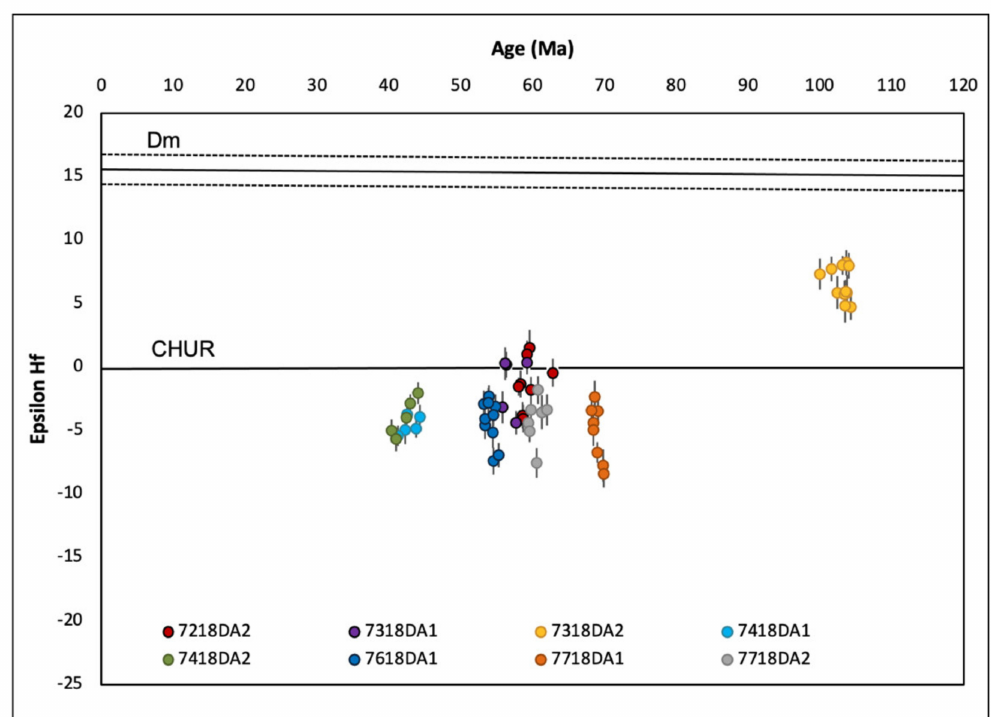
Figure 5. Epsilon Hf ( 176 Hf/ 177 Hf) values for igneous zircons plotted against corresponding U-Pb geochronology crystal- lization ages. More negative values represent more evolved isotopic signatures. Chondritic Uniform Reservoir (CHUR) line depicts expected crustal composition of bulk silicate earth. Depleted Mantle (DM) line represents the natural depletion of incompatible elements within the mantle over time. Note the change in epsilon Hf values from ~100 Ma grains to 70-40 Ma grains. Complete zircon Lu-Hf isotope geochemistry results for individual grains can be found in Supplementary Table